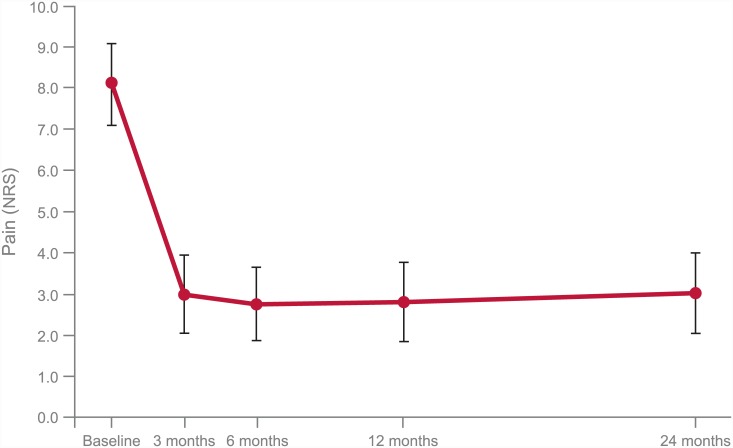
Pain (NRS) scores for baseline, 3, 6, 12 and 24 months after treatment with ACS and physiotherapy.Error bars denote standard deviation. ACS: Autologous conditioned serum; NRS: Numeric Rating Scale.